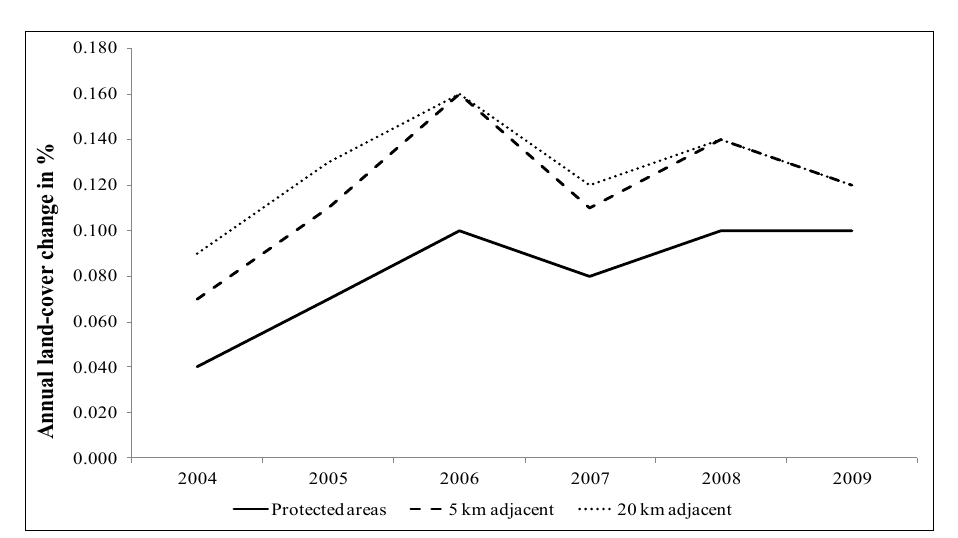
Figure 3. Mean land and forest degradation 2004–2009 for protected areas and adjacent areas showing lower change inside protected areas than in the 5-km and 20-km zones around each protected area and a general trend towards increasing land and forest